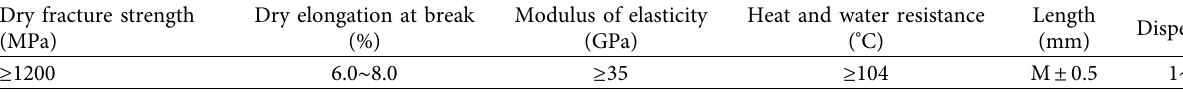
Table 2: Basic mechanical properties of polyvinyl alcohol fiber.